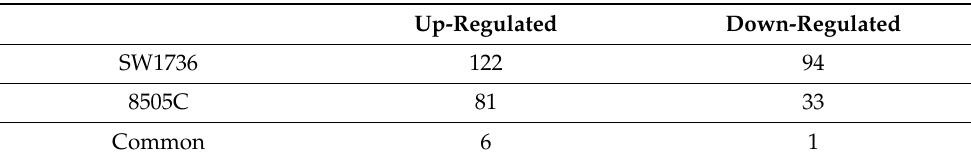
Table 3. Number of m6A-enriched RNAs up- or down-regulated after METTL3 silencing in each cell line (SW1736 or 8505C) and crossing data for the two cell lines (common).